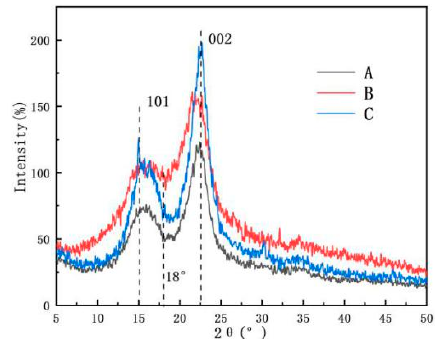
Figure 7. XRD spectra of (A) Artemisia vulgaris bast powder; (B) Artemisia vulgaris bast microcellulose fiber, and (C) Artemisia vulgaris bast nanocellulose fiber.